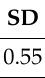
Figure 5. The distance (Å ) of the bonding interactions of carnosine with P-glycoprotein GLU875. Table 3. Summary of distance statistics of the binding of carnosine with P-glycoprotein GLU875. Minimum Maximum Mean SD Carnosine 1.51 5.49 2.9 0.55